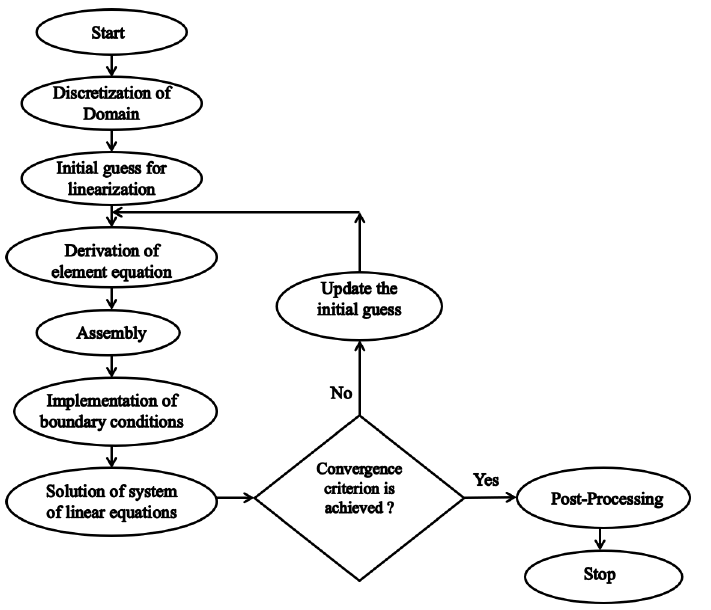
Figure 2. FEM Working Flow